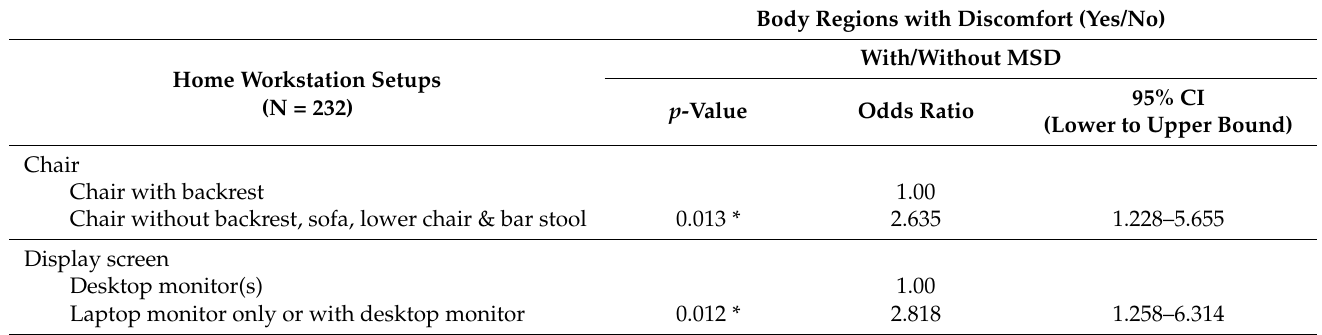
Table 8. Summary of multivariate logistic regression analyses for home workstation and self-reported musculoskeletal